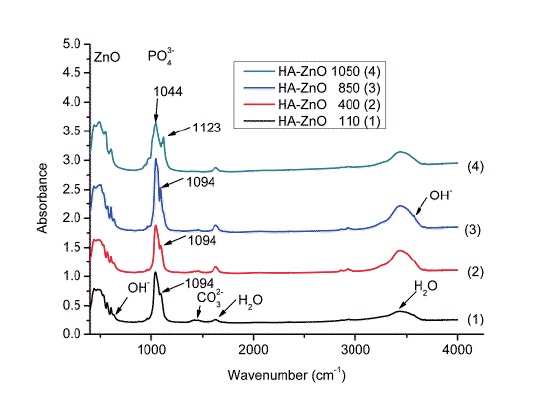
Figure 3: FT-IR spectra of HA-ZnO.